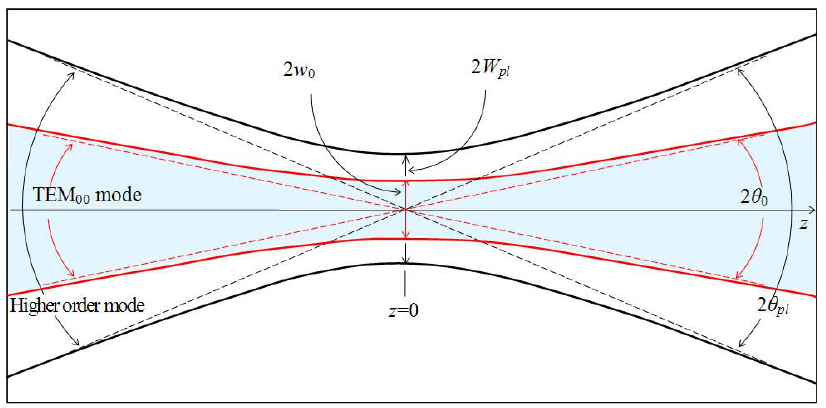
Fig. 3. The embedded Gaussian